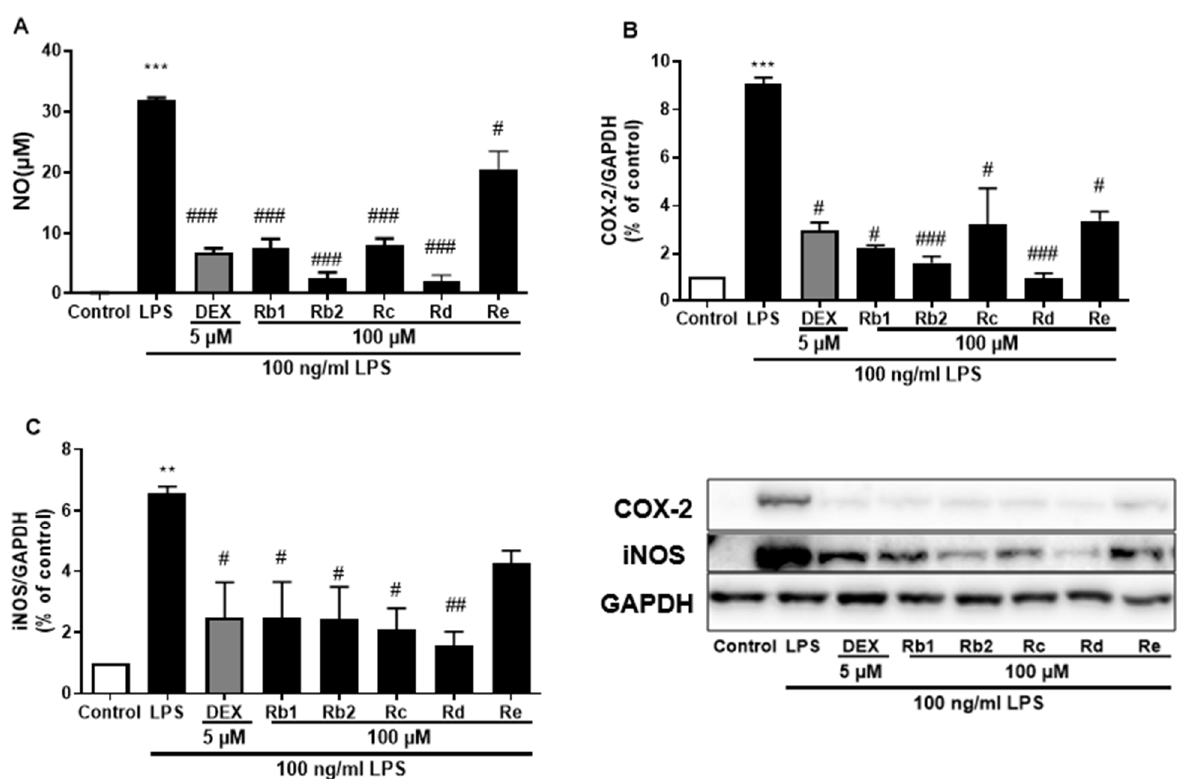
Figure 8. Effect of the ginsenosides on nitric oxide (NO) and iNOS/COX-2 production in LPS-stimulated BV-2 cells. ( A ) NO levels in the cell supernatant were measured by Griess reagent colorimetric reaction. Respective Western blots presenting the expression level of the ( B ) COX-2 & ( C ) iNOS. Experimental results were presented as mean ± SEM. **: p < 0.01, ***: p < 0.001, the significant difference compared with the control. Compared with LPS group, #: p < 0.05, ##: p < 0.01, ###: p < 0.001 (one-way ANOVA followed by Dunnett’s multiple comparisons).